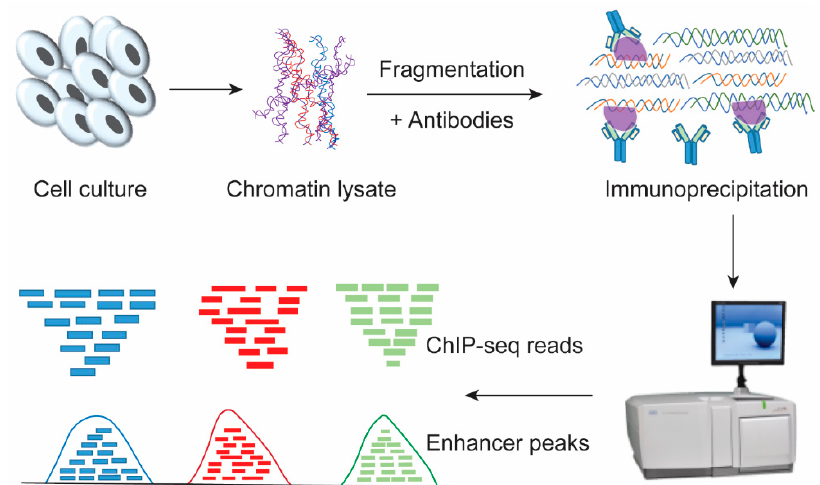
Figure 2. Genome-wide identification of cis-regulatory drivers, the enhancers. The cells were cross-linked with formaldehyde, and glycine was added to stop the reaction. Cell pellets were collected and suspended to isolate the nuclei. Chromatin was prepared by sonication into certain size, and the fragments were incubated with antibodies against target proteins. Then, extraction buffer was added to extract and purify the DNA from the complexes. The target DNA fragments were enriched and sequenced by using ChIP-seq in combination with bioinformatics analysis. According to the called ChIP-seq peaks, the enhancer elements in the chromatin can be identified.